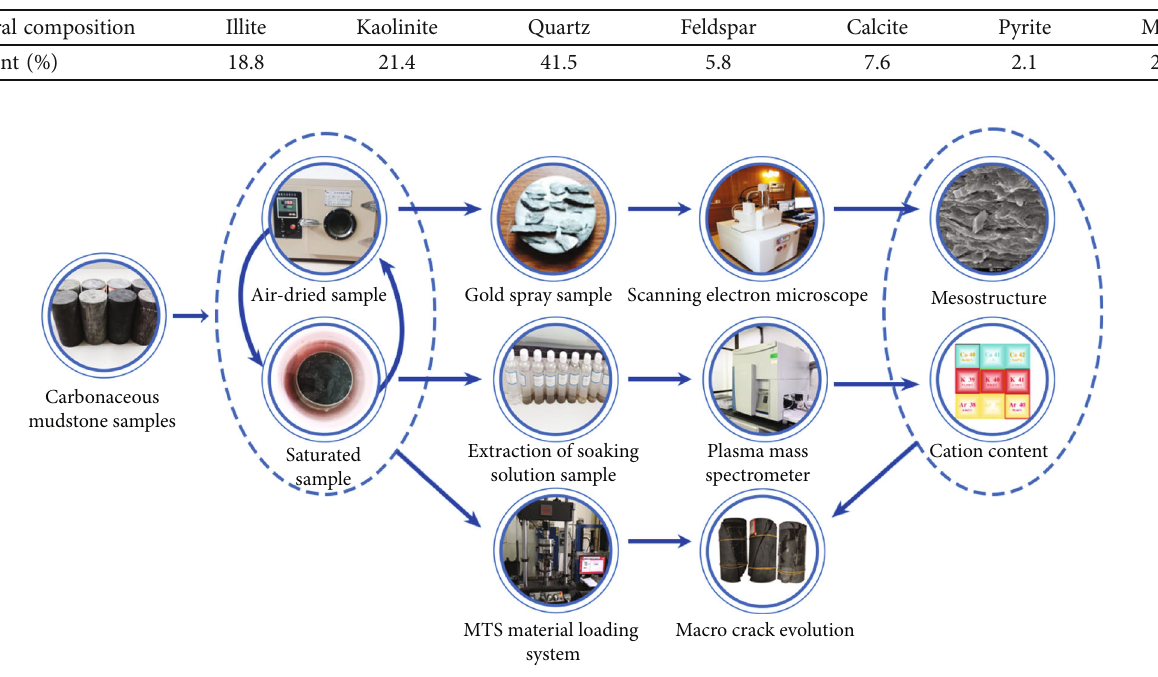
Figure 1: Di ff raction pattern of carbonaceous mudstone. Table 1: The mineral component of carbonaceous mudstone.